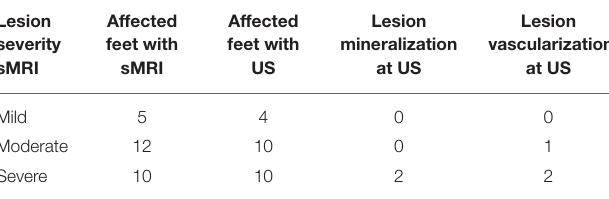
TABLE 3 | Summary of deep digital flexor tendon lesion severity at standing magnetic resonance imaging and comparison with ultrasonographic